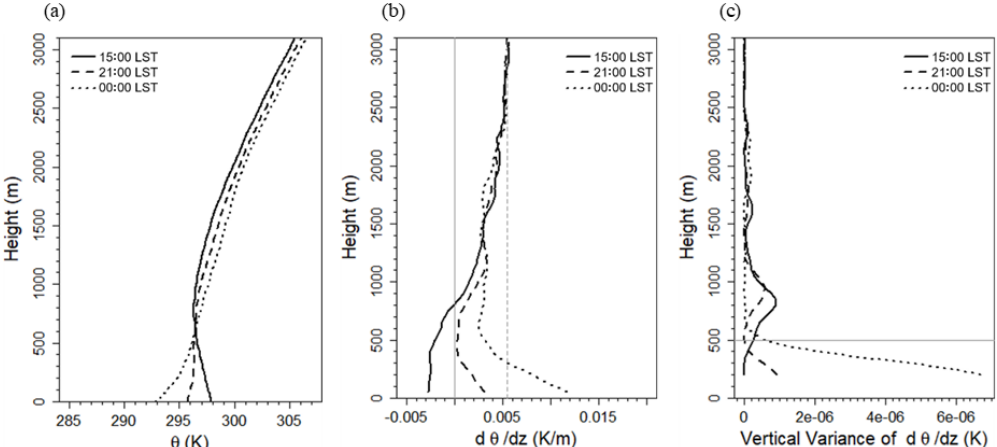
Figure 4. Vertical profiles of (a) potential temperature, (b) gradient of potential temperature, (c) vertical variances of d θ/ d z at 15:00LST (solid line) and 21:00LST (dashed line) on 23 September 2016, as well as 00:00LST (dotted line) on 24 September 2016. The vertical lines in panel (b) denote the theoretical lapse rate (solid gray line) and the environmental lapse rate (dashed gray line). The gray line denotes the altitude at which the vertical variance at 00:00LST on 24 September 2016 decreases